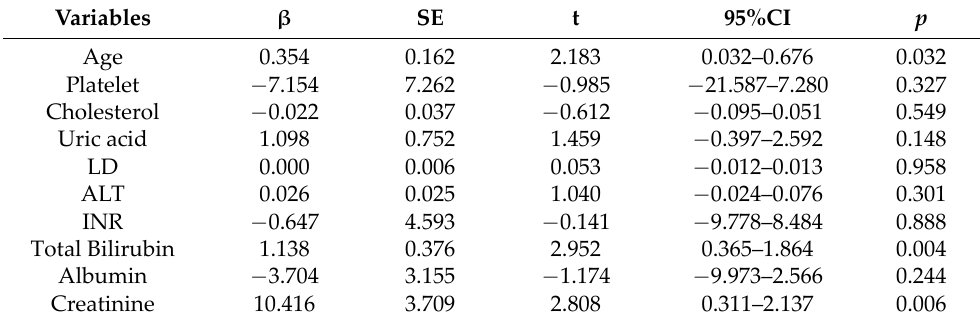
Table 5. Multivariate linear regression